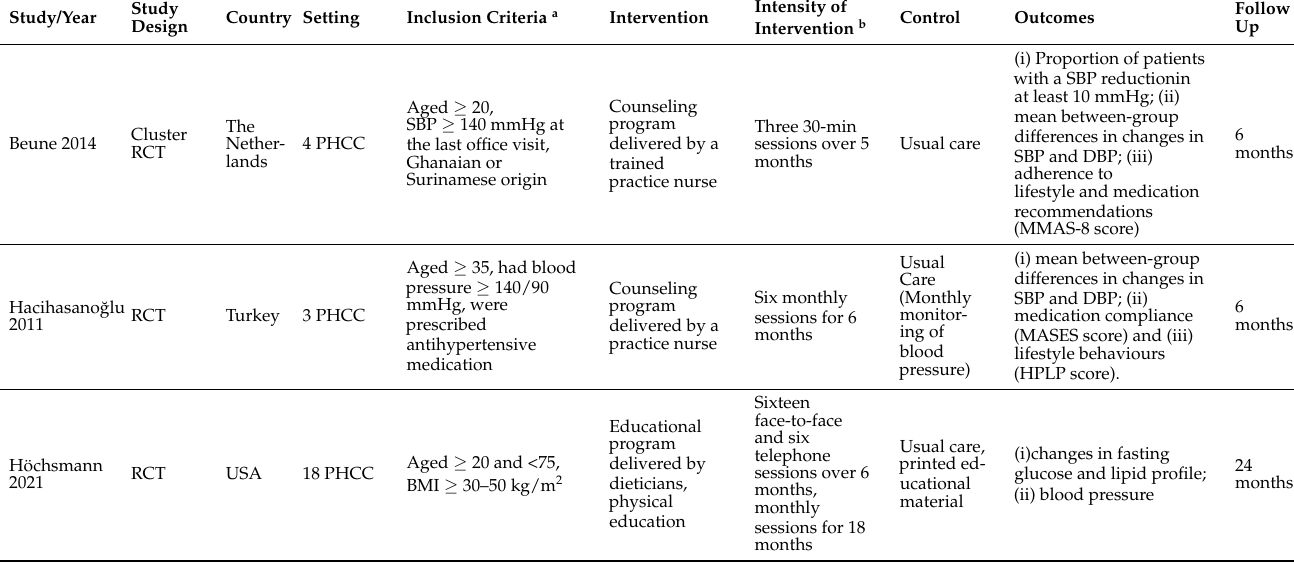
Table A1. Characteristics of included studies according to the eligibility criteria for studies offering nutritional therapy primarily for